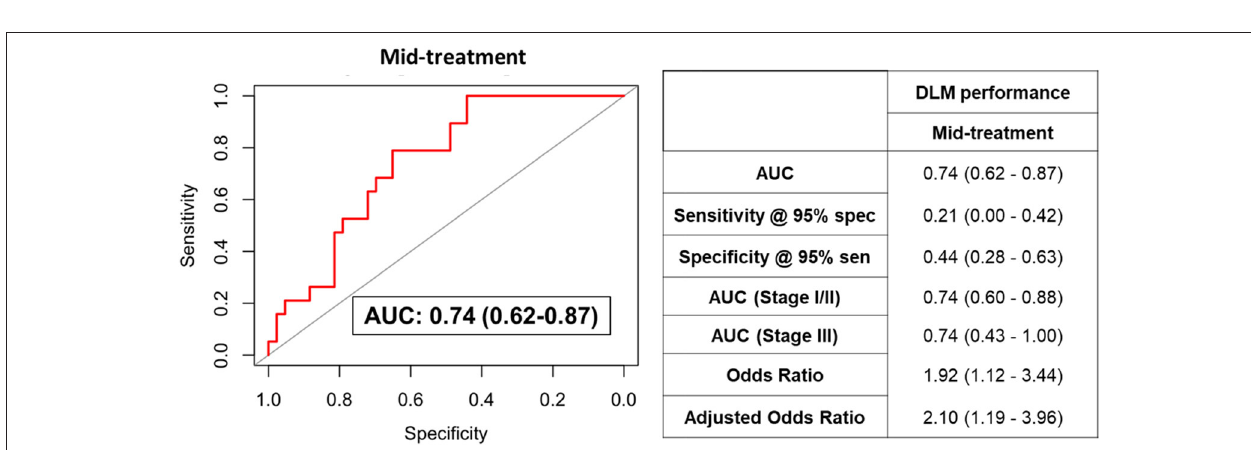
FIGURE 3 | ROC curve for the DLM for distinguishing TNBC patients that went on to have RCB-II/III following NACT from those that had RCB-0/I using plasmas collected after four cycles of AC. Table provides tabulated performance estimates of the DLM. † Age and stage were included as covariables in adjusted odd